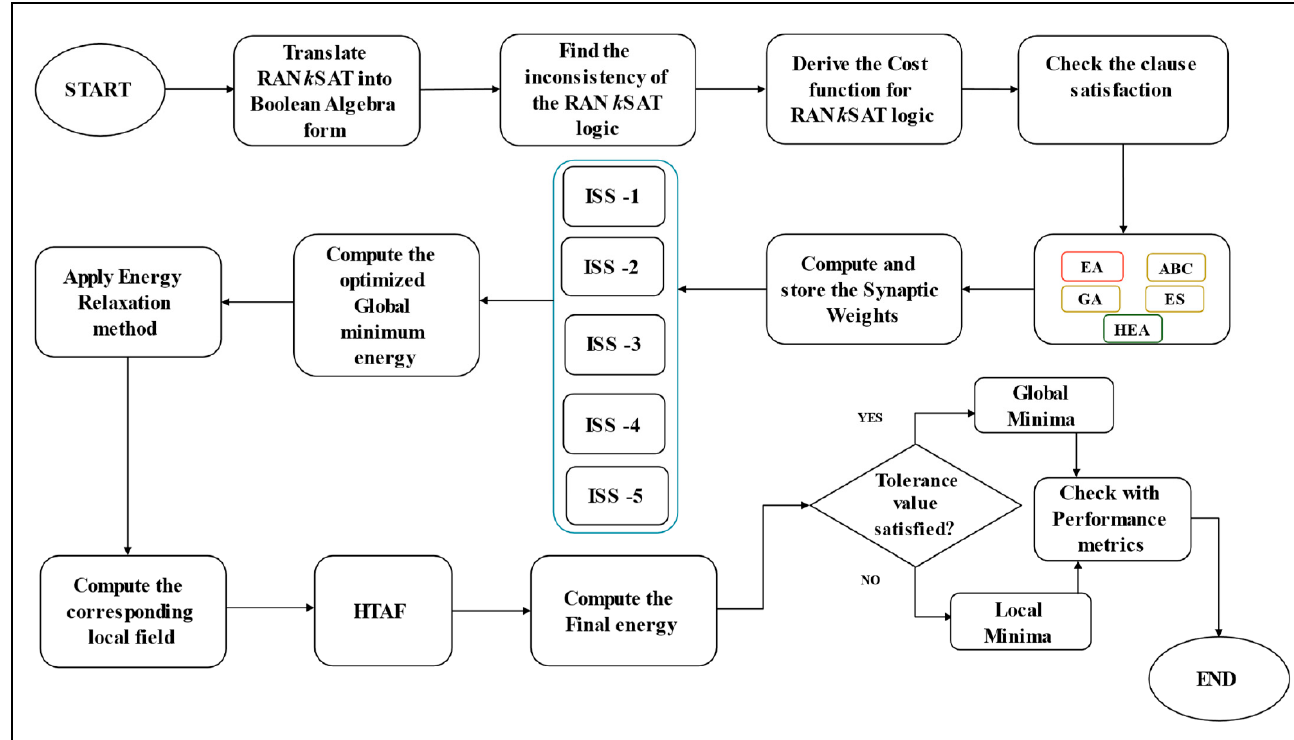
Figure 3. Flowchart of DHNNRAN k SAT-HEA, DHNNRAN k SAT-EA, DHNNRAN k SAT-ES, DHNNRAN k SAT-GA and DHNNRAN k SAT-ABC.